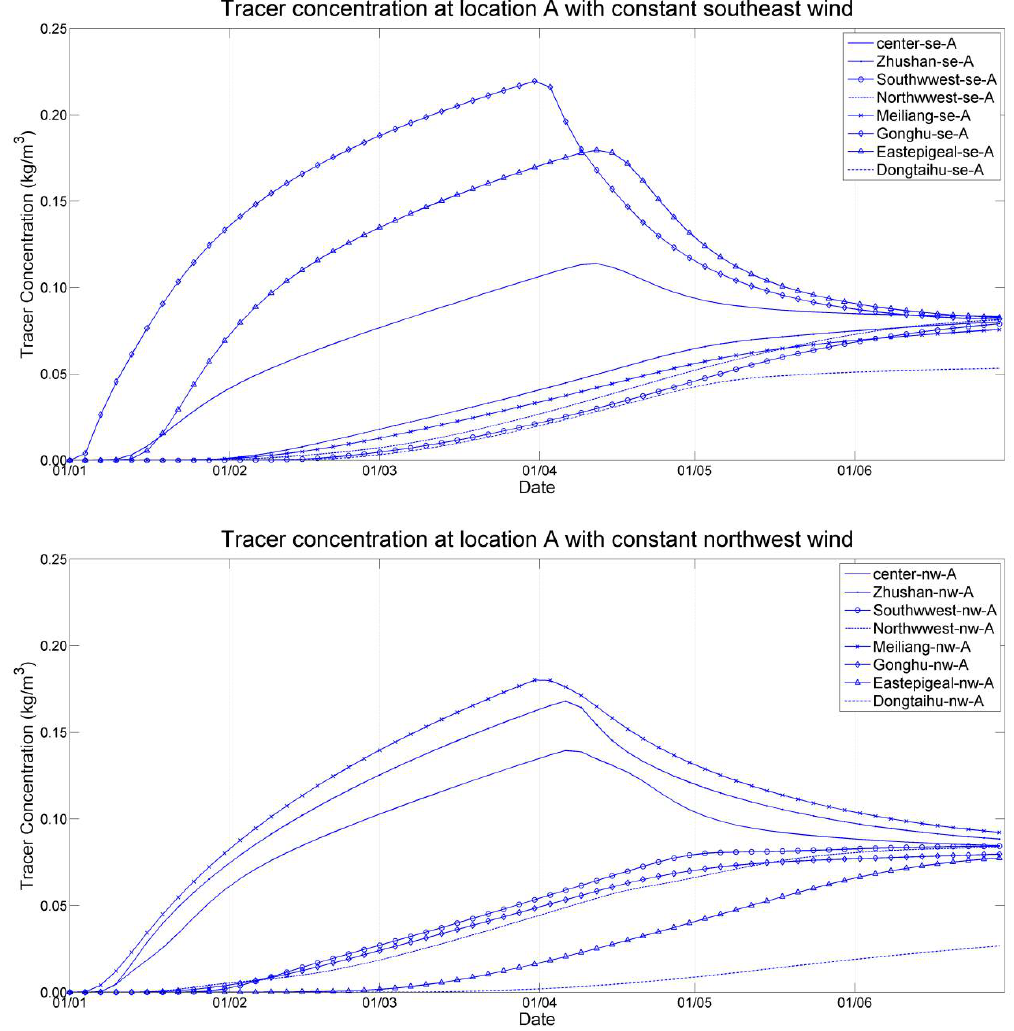
Figure 18. Tracer concentration at location A with different tracer release spot, the upper subplot shows tracer concentration with constant 5 m/s southeast wind condition, while the lower subplot describes the northwest wind condition. To make the plot clearer, data are extracted per 3 days from the model results.